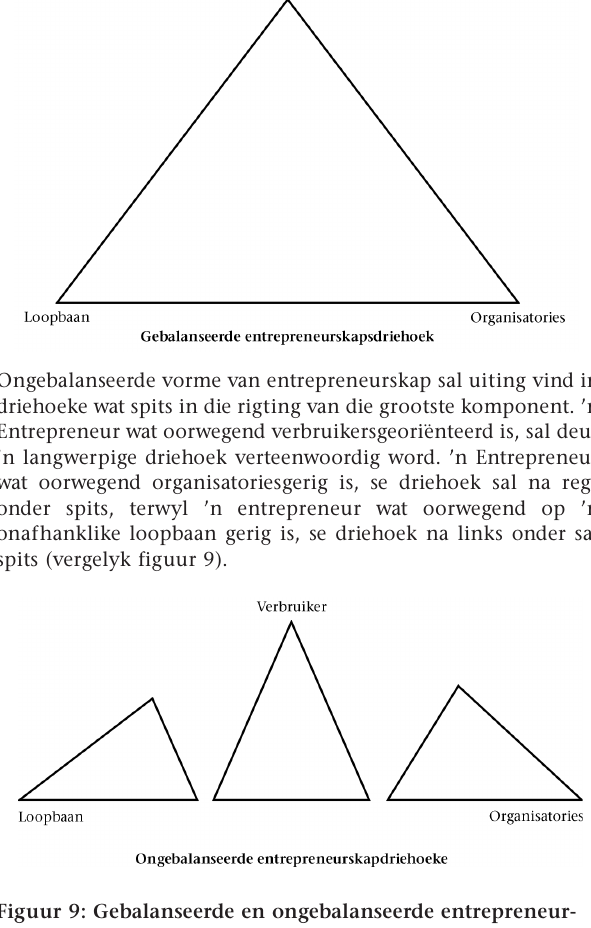
Figuur 9: Gebalanseerde en ongebalanseerde entrepreneur- skapsverhoudings (na die idee van Sternberg, 1987)